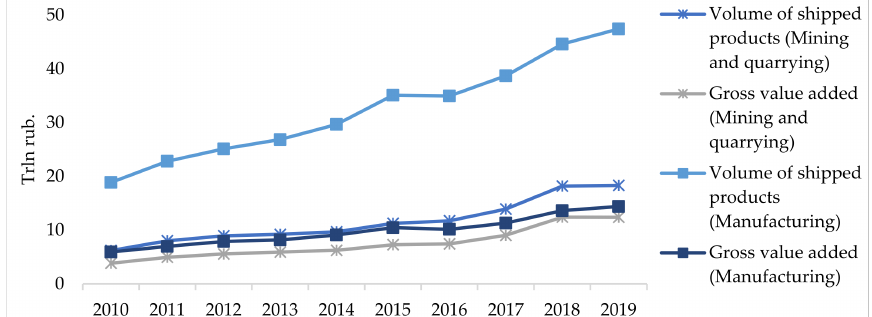
Figure 1. Dynamics of economic indicators of industrial development in